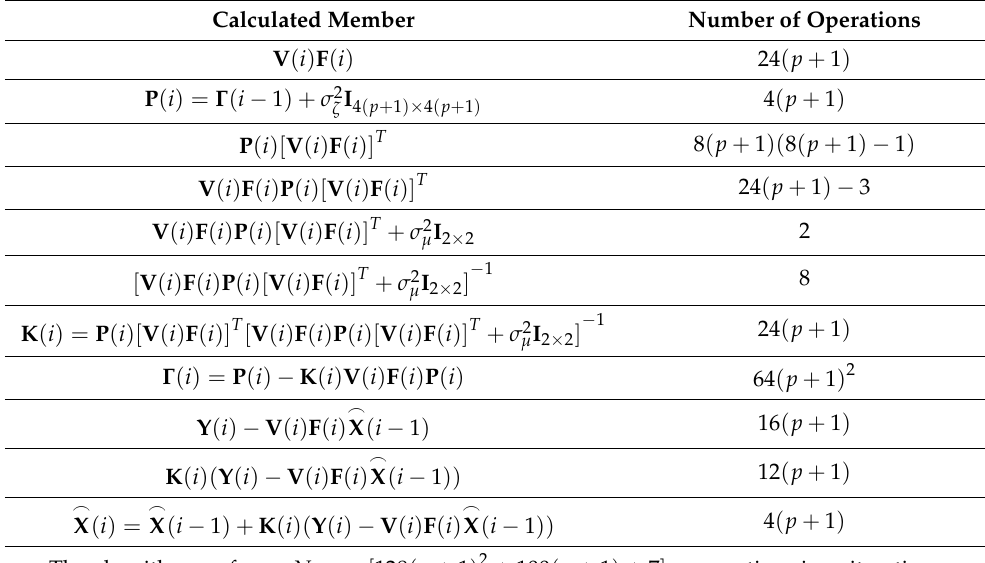
Table 3. Calculation of the computational complexity of the algorithm [31] for SISO systems.